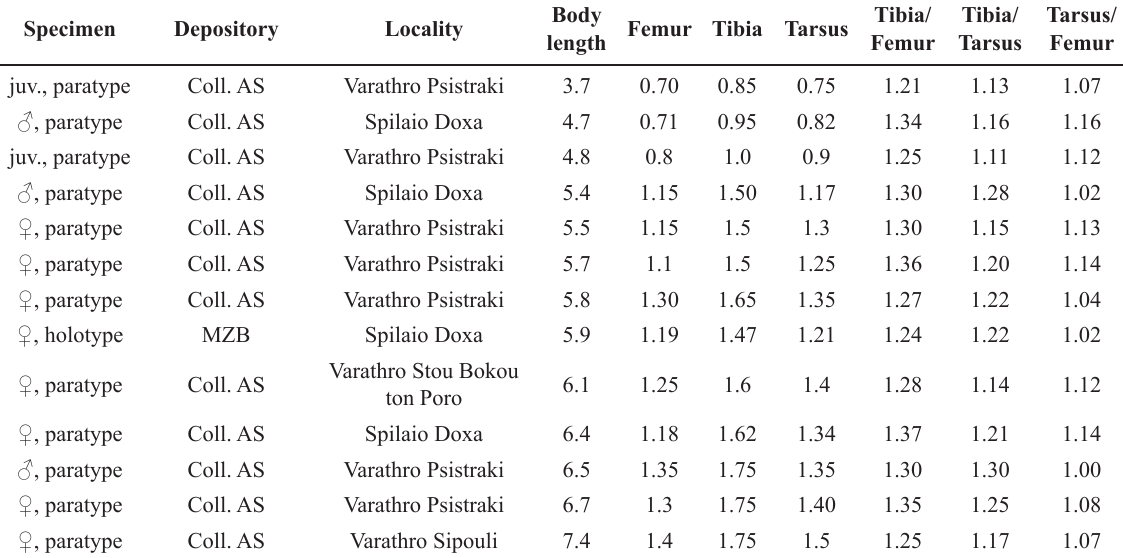
Table 7. Plusiocampa ( Plusiocampa ) hoffmanni Sendra & Paragamian sp. nov. Length of the body, metathoracic legs and their segments: trochanter, femur, tibia and tarsus (measurements in mm).